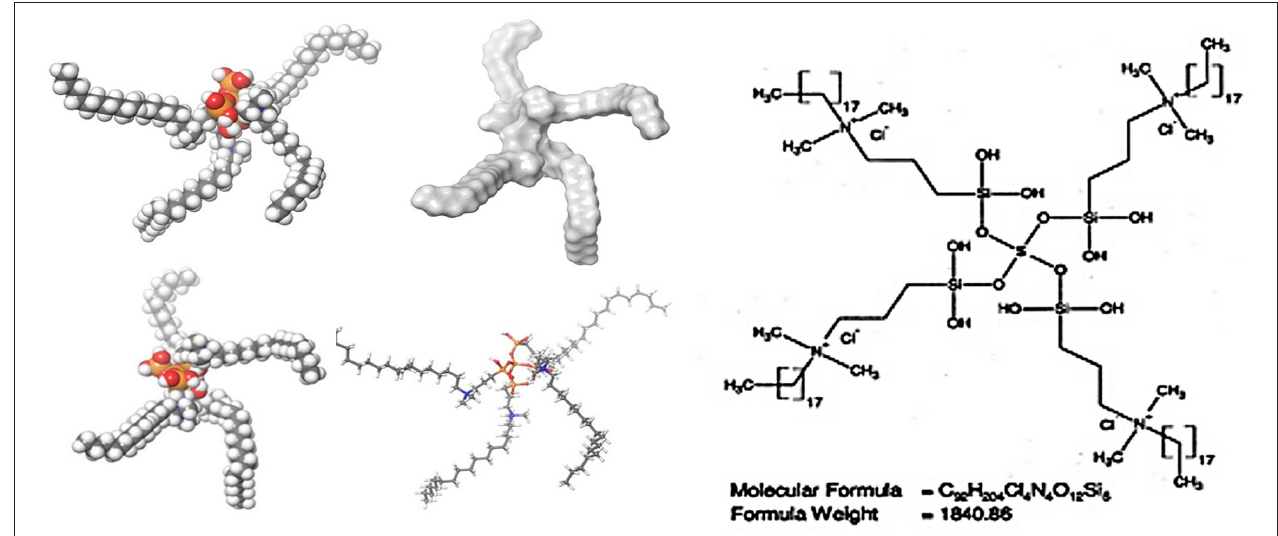
FIGURE 1 | Chemical and molecular structure of